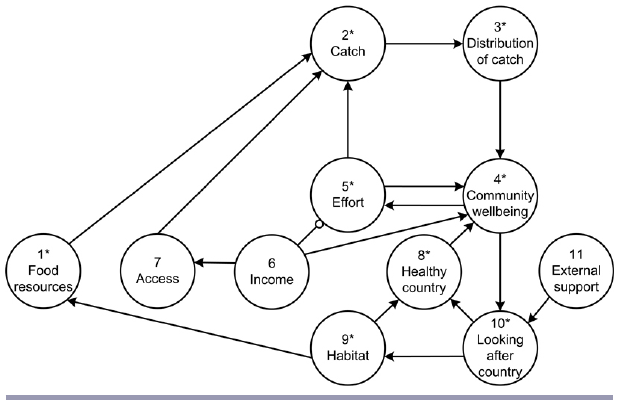
Fig. 1. Generalized model of aquatic subsistence activity in indigenous communities of North Australian river catchments. See Tables 1 and 2 for descriptions of model nodes and